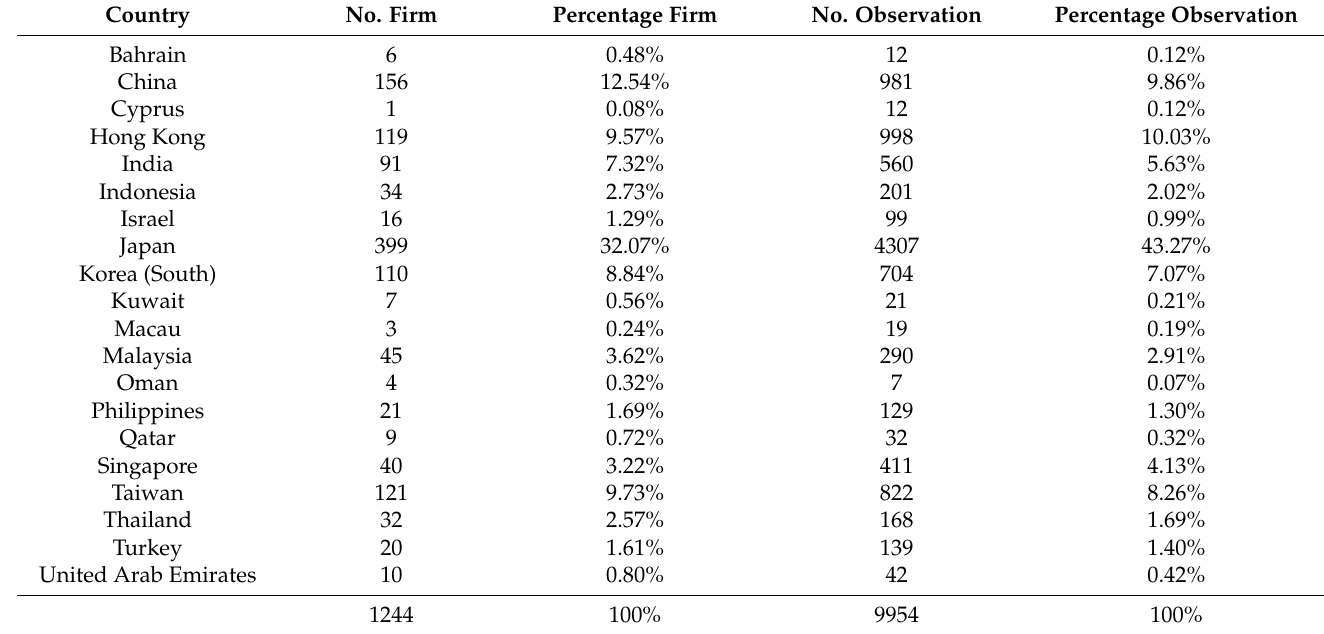
Table 1. Sample of public listed companies in Asian countries from 2005 to